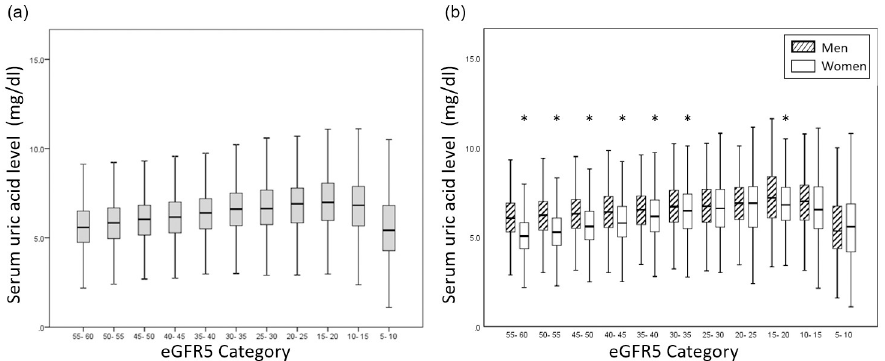
Fig 1. Mean serum uric acid level according to eGFR5 category. (a) All participants; (b) Men and women shown separately. Abbreviation: eGFR, estimated glomerular filtration rate. � , p < 0.05.